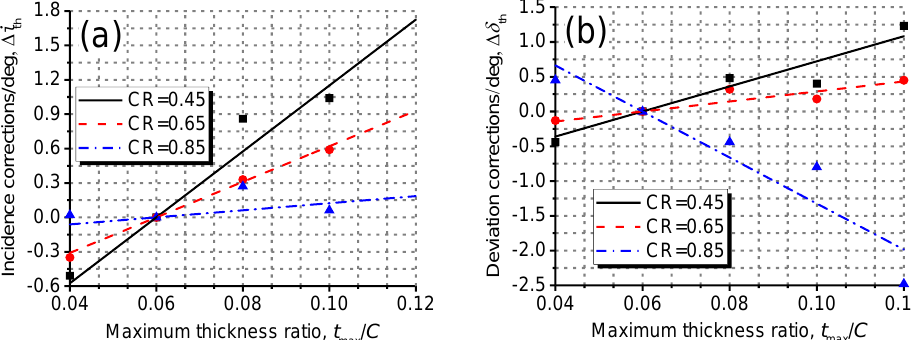
Figure 15 . Correction curves of ( a ) incidence and ( b ) deviation angle correlations as a function of the maximum thickness-chord ratio and the CR.